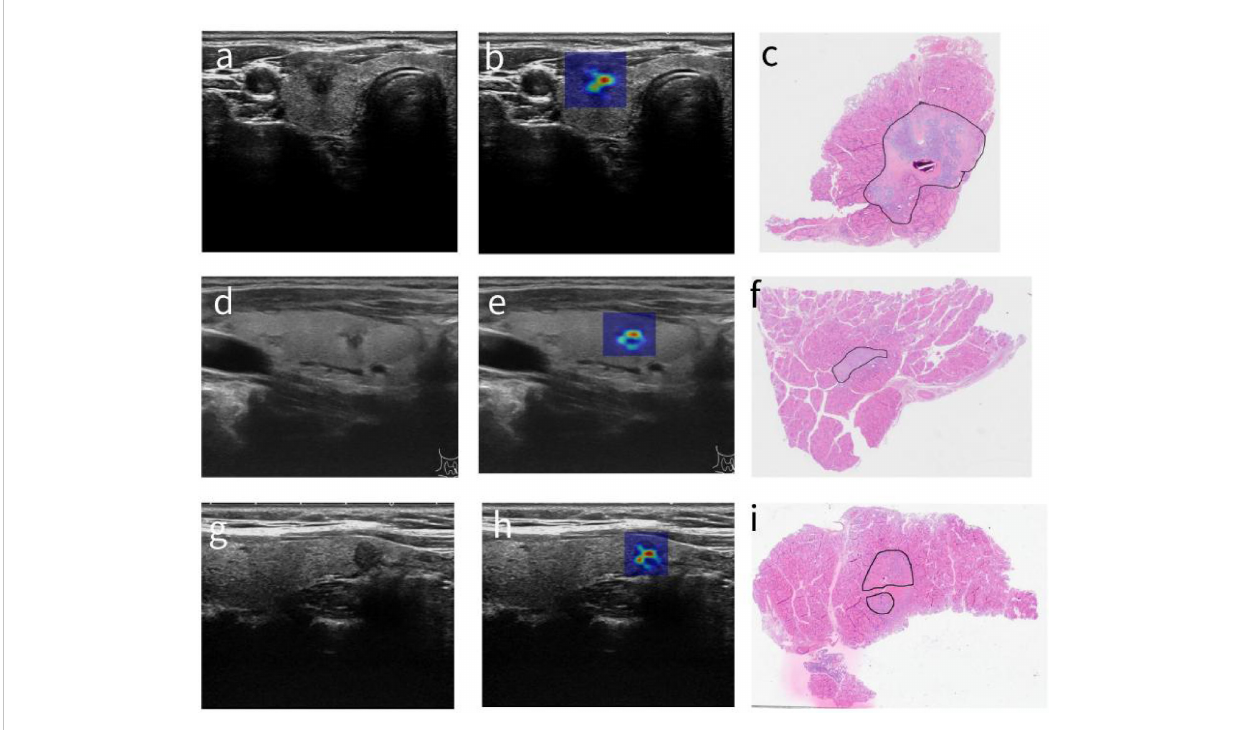
FIGURE 8 Correspondence of post-operation pathological images and malignancy heat maps computed on ultrasound images. (A, D, G) The original thyroid ultrasound images. (B, E, H) The superimposed images for the corresponding nodules and heat maps. (C, F, I) The cropped zoomed-in pathological